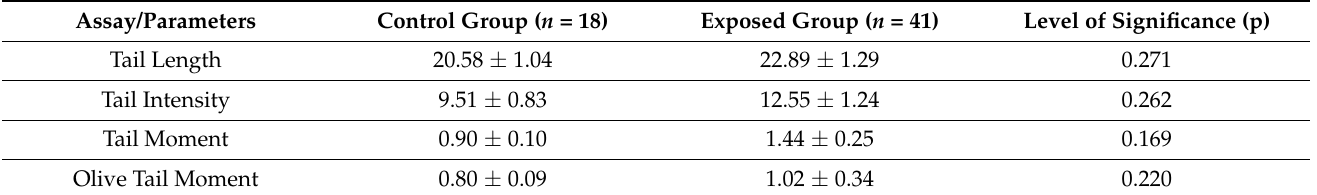
Table 3. Human biomonitoring of agricultural workers from Los Reyes in Michoacan Mexico, with Comet